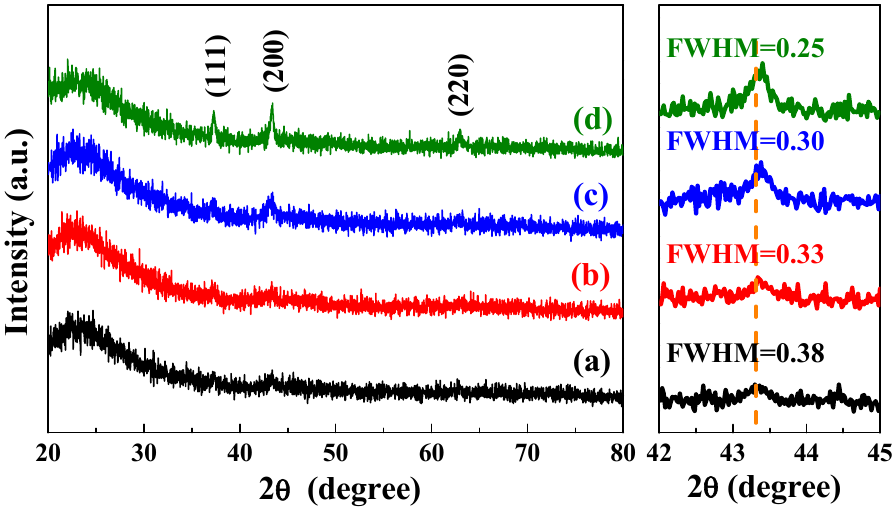
Figure 3. X-ray diffraction patterns of the L2NiO thin films as a function of the annealing temperatures and times: ( a ) 400 ° C for 1 h, ( b ) 400 ° C for 3 h, ( c ) 500 ° C for 3 h, and ( d ) 600 ° C for 3 h.